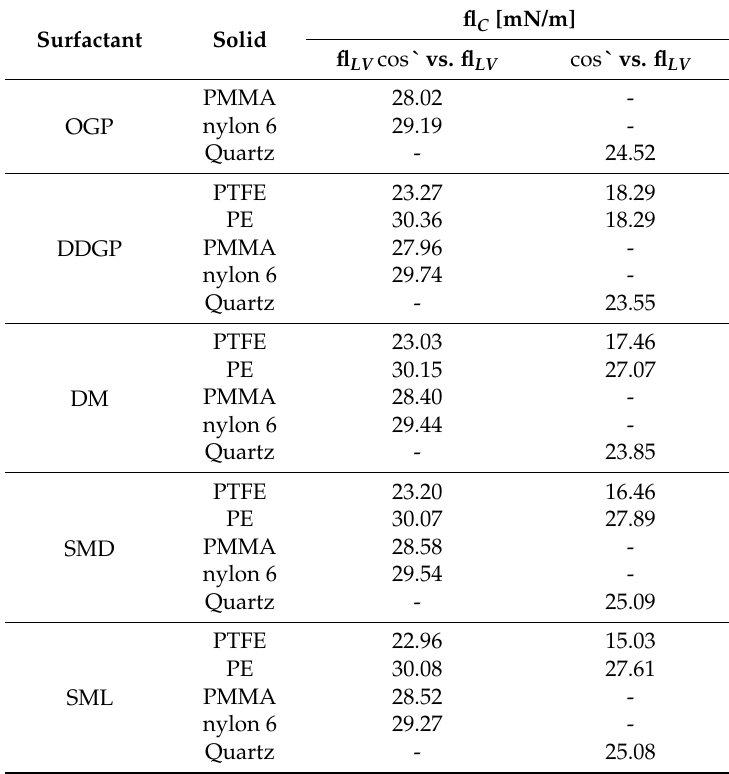
Table 4. The values of the solid critical surface tension of wetting ( γ C